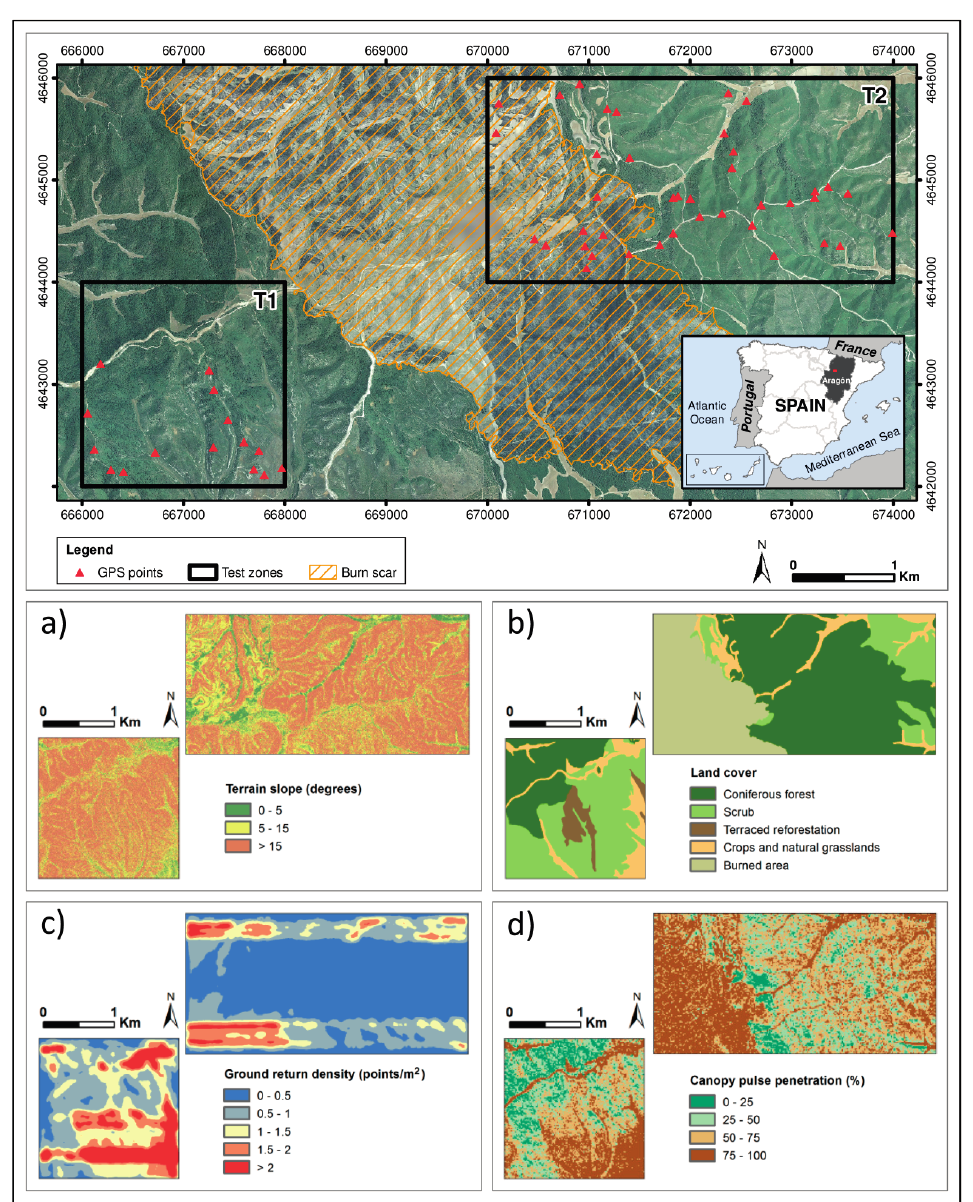
Figure 1. Study area with the two test sites (T1 and T2) and factors influencing DEM accuracy: ( a ) Terrain slope; ( b ) Land cover; ( c ) Ground return density; ( d ) Canopy pulse penetration. The red triangles denote the locations of the reference GPS benchmarks used in the accuracy assessment overlaying a high spatial resolution PNOA-orthophotography captured in